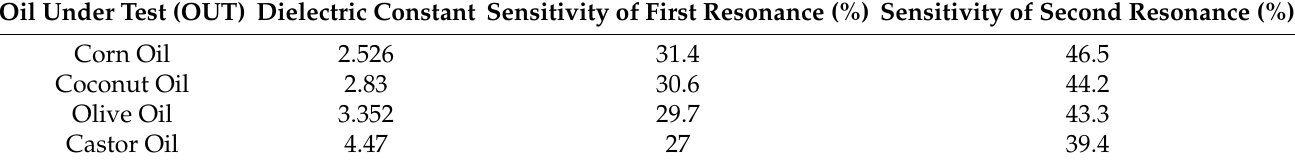
Table 4. Relative sensitivity of the complementary metaresonator sensor with respect to